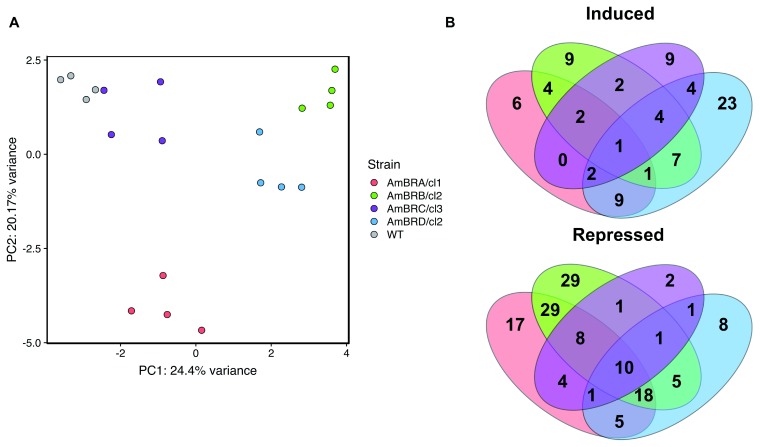
Overall trends in untargeted metabolomics data.
A) Principal component analysis performed on range-scaled data. The 319 identified metabolites that met filtering criteria (see Methods) were all included.
B) Venn diagrams showing overlap of metabolites induced or repressed across different AmB-resistant lines. Metabolites included are those with Benjamini-Hochberg-corrected p-value (q-value) < 0.05 for ANOVA, and a Tukey’s Honest Significant Difference test comparing to wild-type with p-value < 0.05.